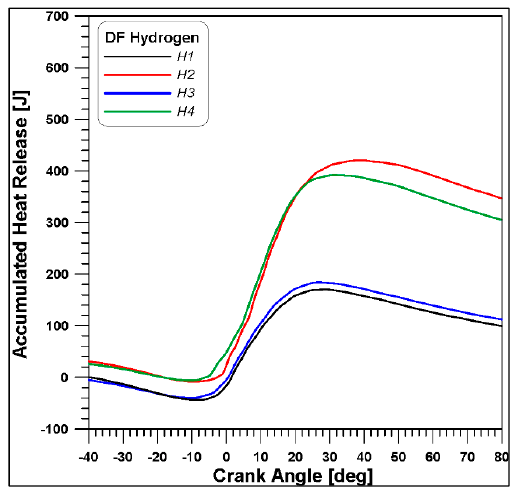
Figure 5. Accumulated heat release. Cases with methane.